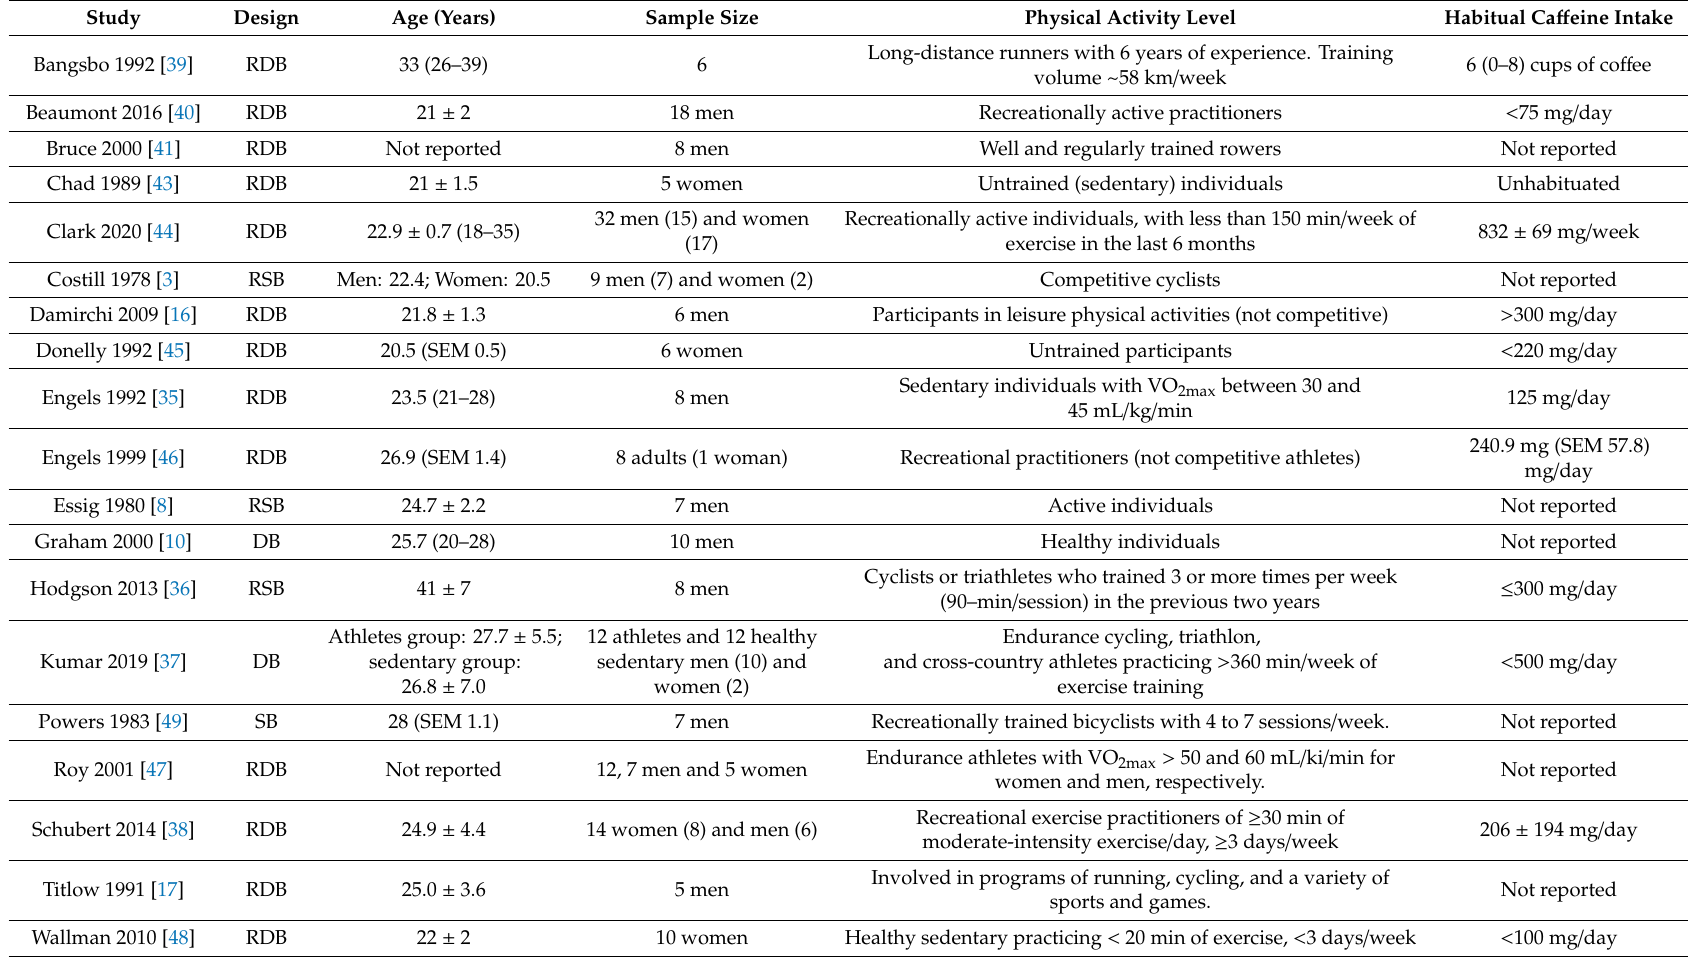
Table 2. Summary design and